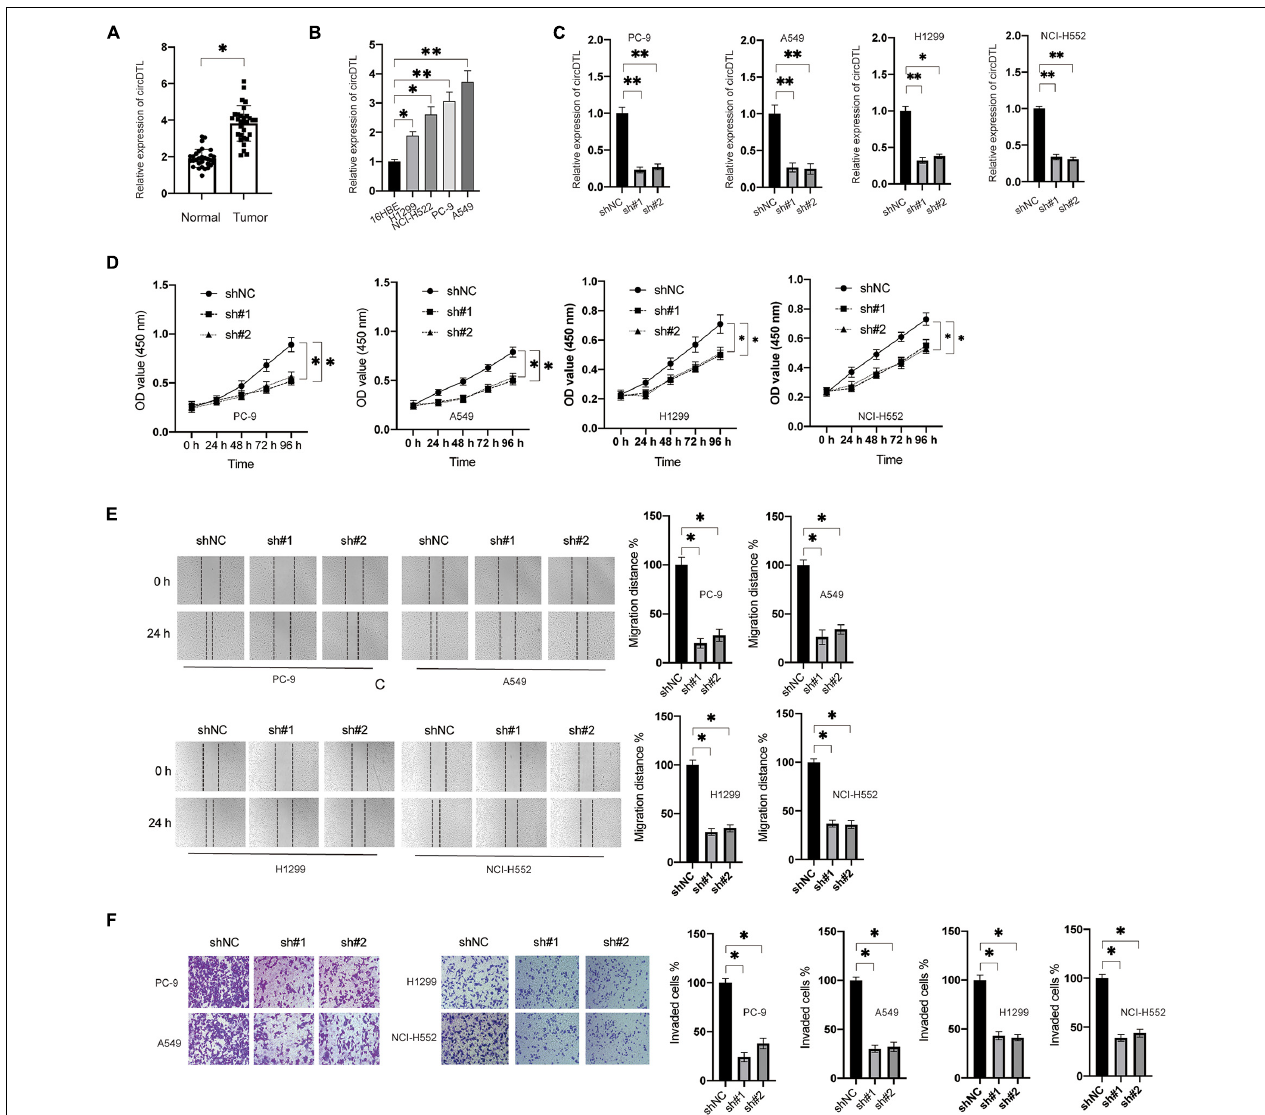
FIGURE 1 | circDTL was upregulated and acted as an oncogene in NSCLC. (A) Levels of circDTL in 84 pairs of NSCLC and adjacent tissues. (B) Levels of circDTL in normal cell line BEAS-2B and NSCLC cell lines. (C) NSCLC cells were transfected with shNC or shRNA against circDTL (sh#1, sh#2) for 24 h, levels of circDTL were measured. (D) NSCLC cells were transfected as indicated and cell viability was measured at different time points. (E) NSCLC cells were transfected as indicated, cell migration was assayed. (F) Cell invasion was measured. Data were presented as mean ± SD. Experiments were performed at least three times. ∗ P < 0.05; ∗∗ P <